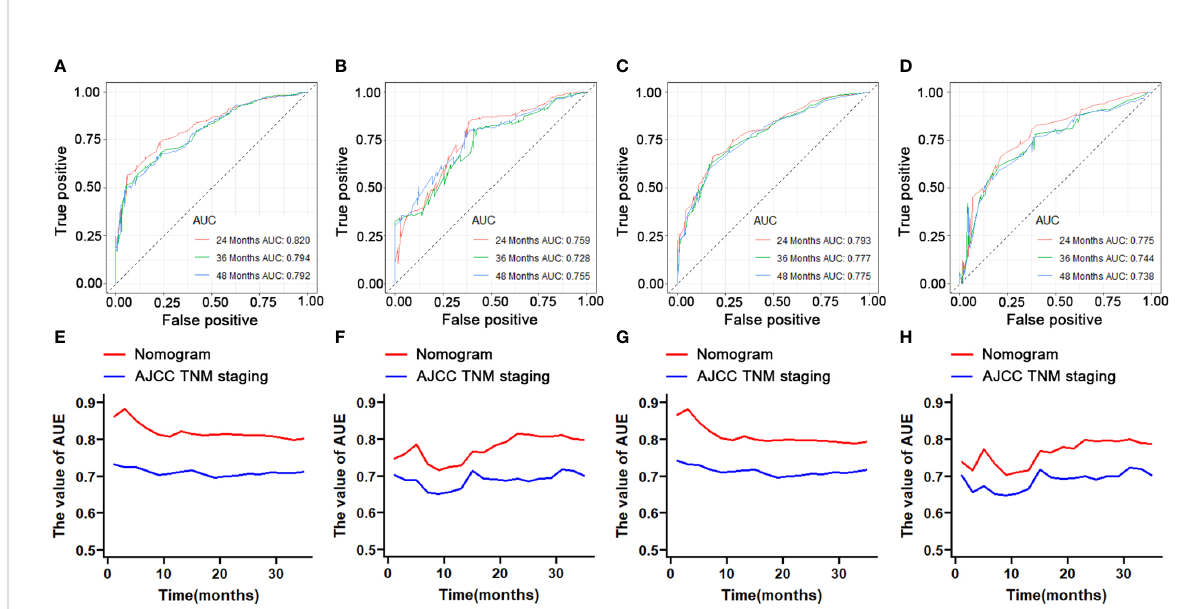
FIGURE 8 ROC curve analysis of the nomogram for the 24-, 36-, and 48-month in the training set (part A , OS; part C , CSS) and the testing set (part B , OS; part D , CSS). The time-dependent ROC curves for comparison of the discriminative ability between nomogram and TNM staging system in the training set (part E , OS; part G , CSS) and testing set (part F , OS; part H ,